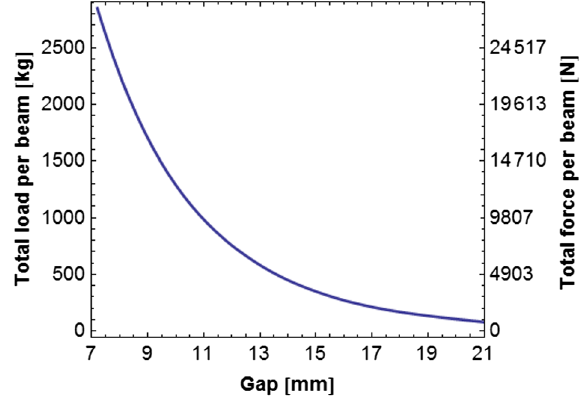
FIG. 10. Gap dependence of the magnetic force attracting the HGVPU strongbacks toward one another.